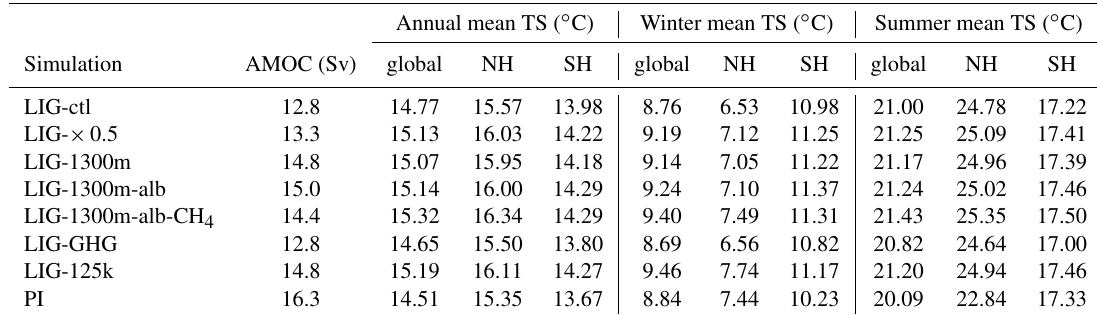
Figure 2. Effect of (a–c) Greenland Ice Sheet elevation and (c, d) albedo in the 130kyrBP simulations. Annual mean surface temperature (TS) anomalies for (a) LIG- × 0.5 minus LIG-ctl, (b) LIG-1300m minus LIG-ctl, (c) LIG-1300m-alb minus LIG-ctl, and (d) LIG-1300m-alb minus LIG-1300m. Hatched areas mark statistically insignificant TS anomalies. Table 2. Atlantic Meridional Overturning Circulation (AMOC) and absolute values of surface temperature (TS) for global, Northern Hemi- sphere (NH), and Southern Hemisphere (SH) coverage, calculated for annual mean, local summer mean (warmest month), and local winter mean (coldest